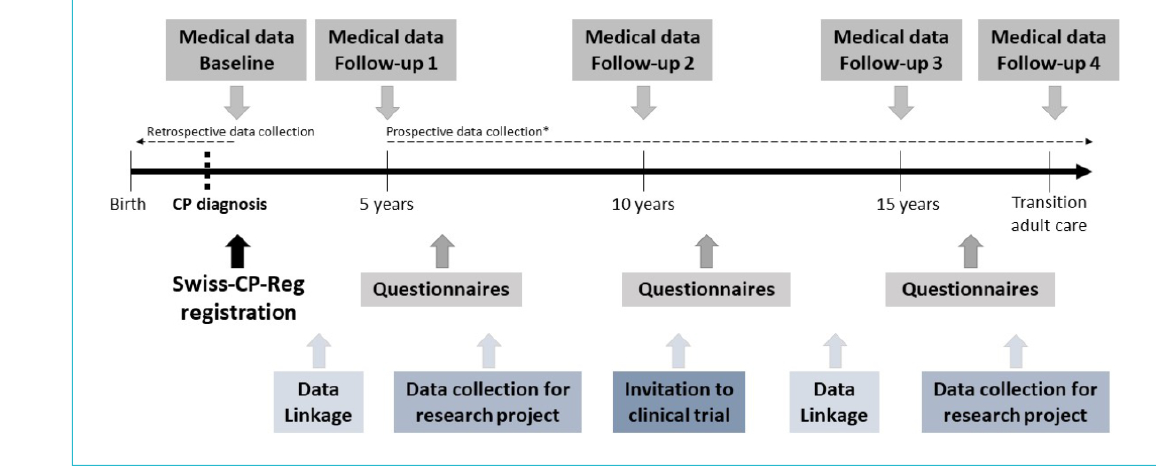
Figure 2: Schematic flow chart of the Swiss Cerebral Palsy Registry; data collection management and timelines. CP, cerebral palsy; Swiss- CP-Reg, Swiss Cerebral Palsy Registry * Medical follow-up data can be collected retrospectively if a participant is registered after the age of 5